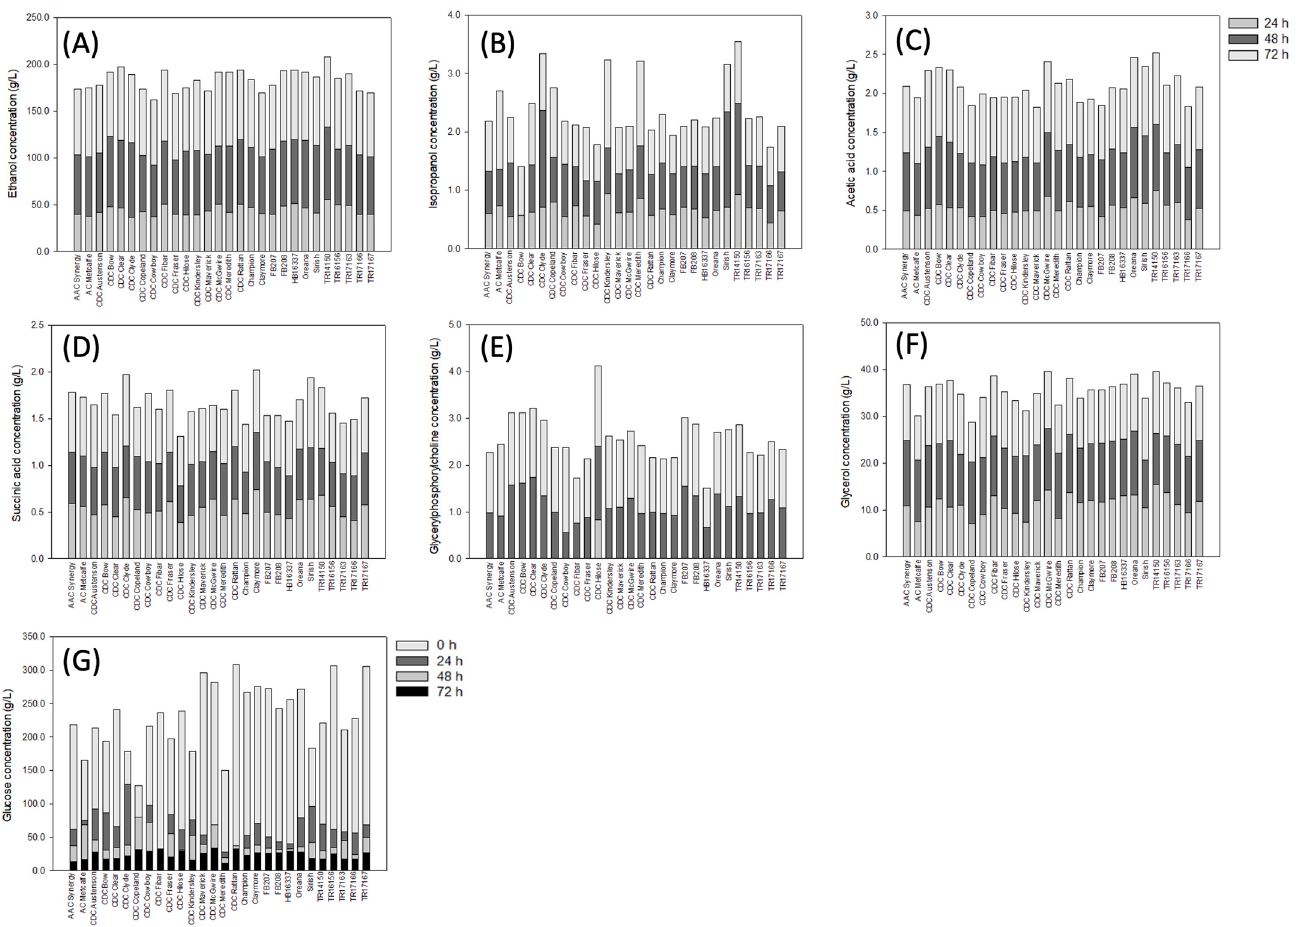
Figure 1. Concentration of ethanol ( A ), isopropanol ( B ), acetic acid ( C ), succinic acid ( D ), α -glycerylphosphorylcholine ( E ), glycerol ( F ) and glucose ( G ) in mash sampled every 24 h during yeast fermentation of different barley cultivars.